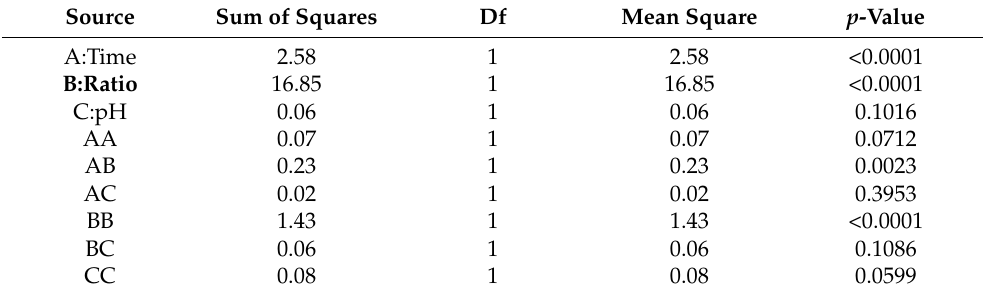
Table 2. Analysis of variance for TPC (g GAE/L), significant factors are highlighted in bold. Source Sum of